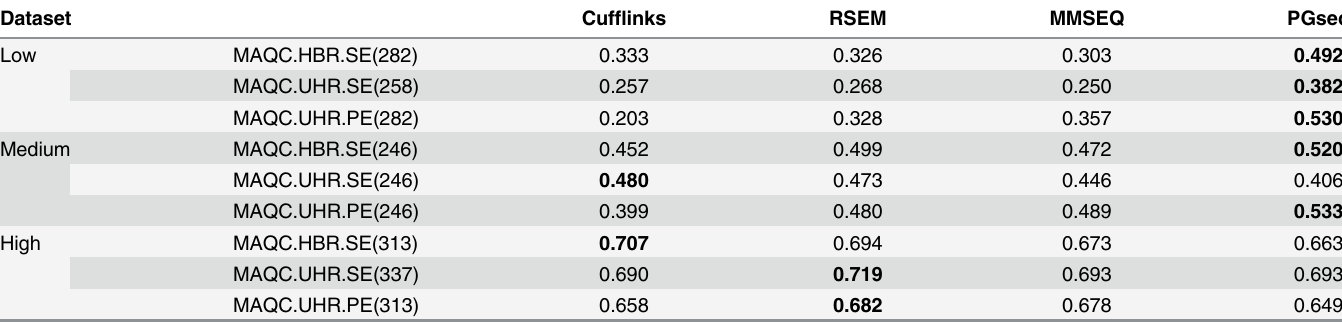
Table 2. Comparison of gene expression estimation accuracy for groups with different level of expression. Dataset